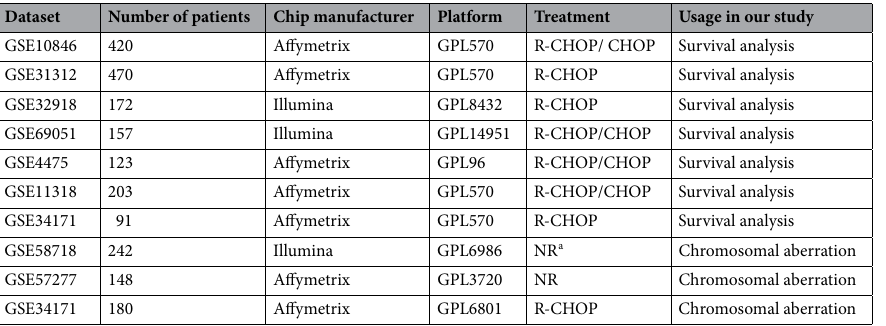
Table 4. Clinical characteristics of the microarray datasets used in our study. a Not recorded.